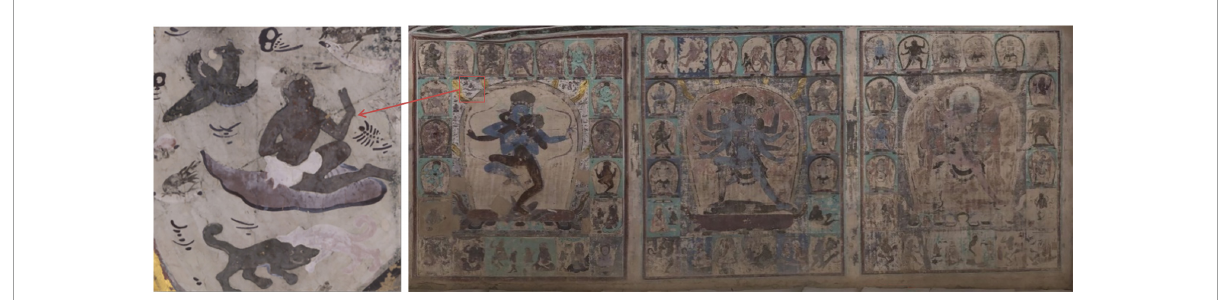
FIGURE2 The mural image of the mandala from Cave 465, Mogao Grottoes (Yuan dynasty, 1271–1368 AD).